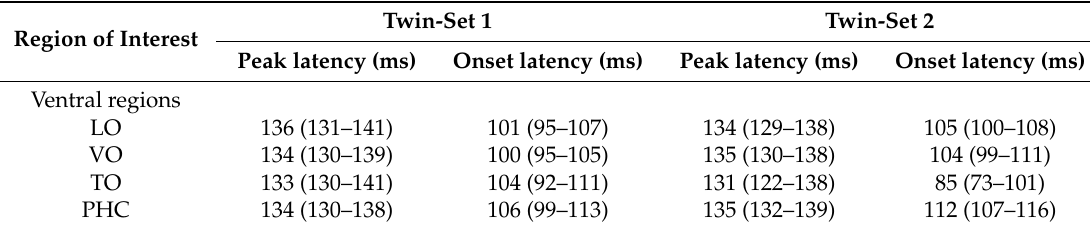
Values are averaged over n = 15 subjects with 95% confidence intervals reported in parentheses. Table 2. Peak and onset latency for fMRI-MEG fusion time series in EVC, ventral, and dorsal regions for Twins-Set (Experiment 1) and ImageNet-Set (Experiment